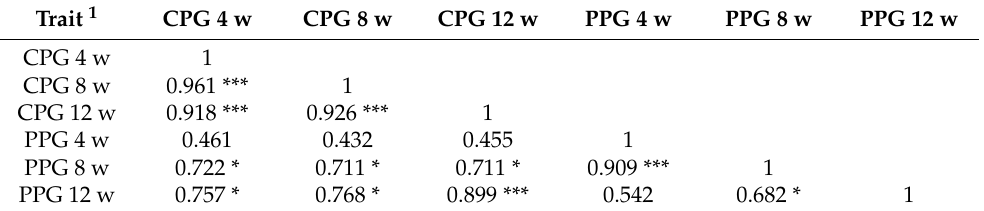
Table 3. Correlation coefficients between observed